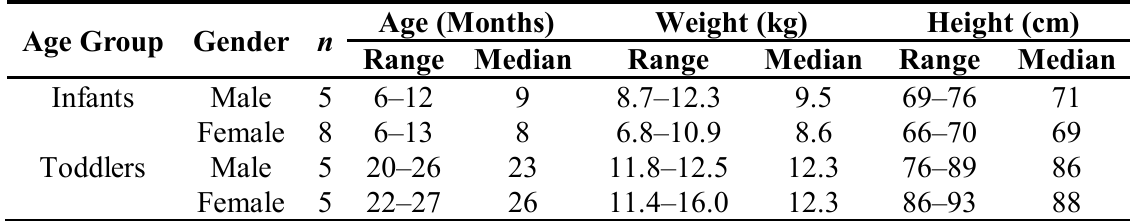
Table 2. Farmworker children’s demographics and physiological characteristics.